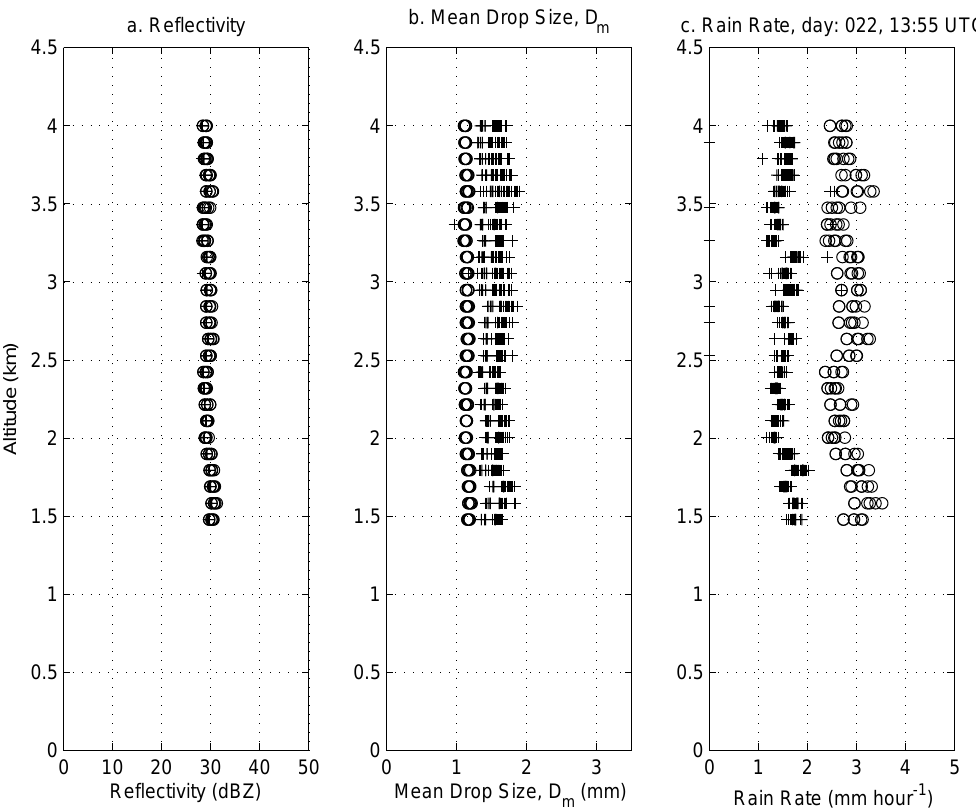
Fig. 5. Retrieved (a) reflectivity, (b) mean diameter D m , and (c) rain rate for each of the 42 DSD retrievals and at each of the 25 range gates for 22 January 2006 at 13:55UTC. The Marshall-Palmer (MP) DSD model retrievals are shown with circles and all other DSD models are shown with pluses. The MP solutions are over-constrained for this data set and produce D m and R that are not consistent with the other retrievals. MP DSD models are not used in any of the ensemble